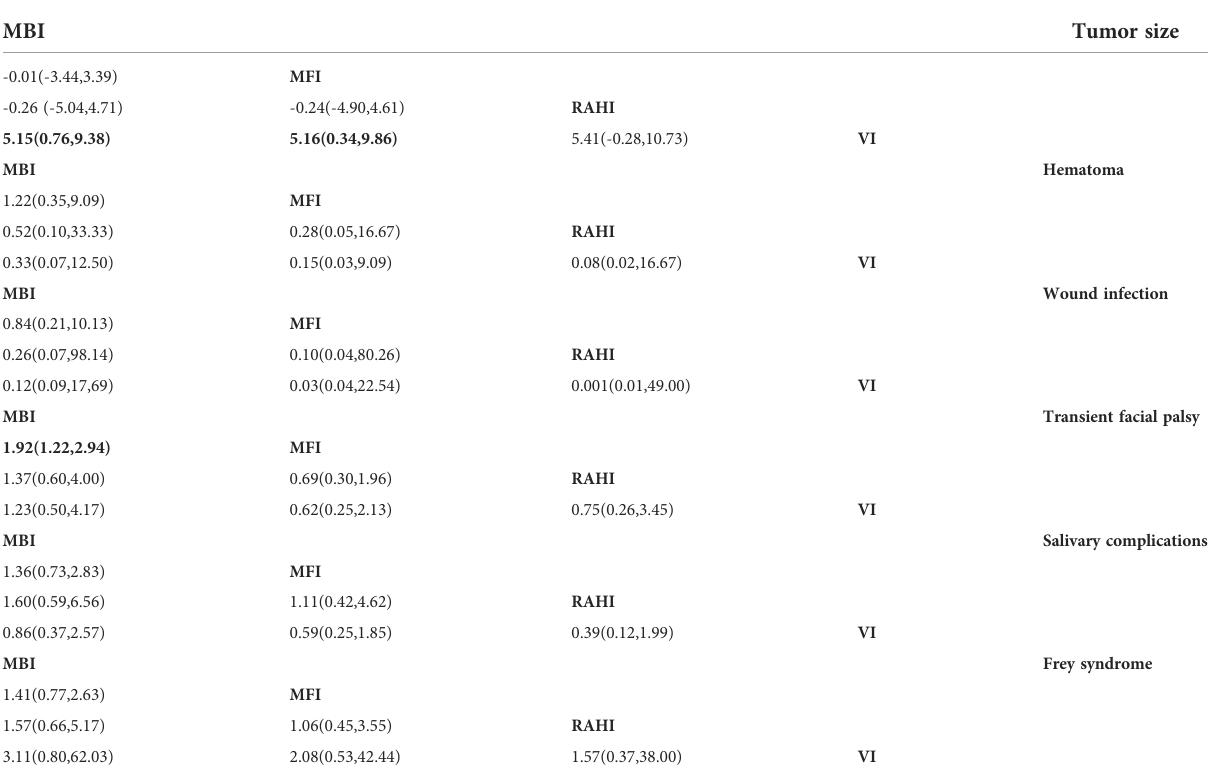
TABLE 5 League table of secondary